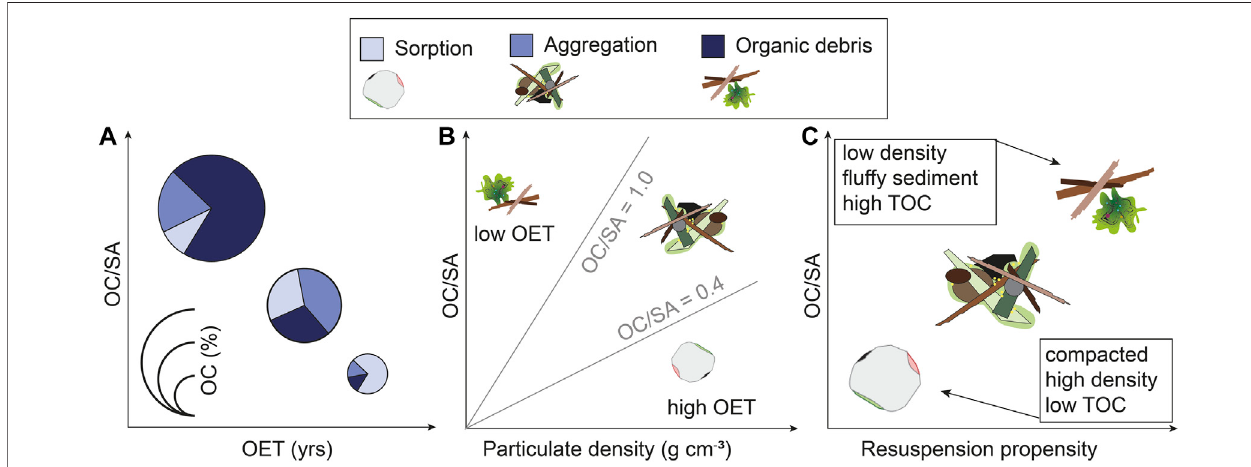
FIGURE 10 | Conceptual schematic illustrating the different factors interacting with each other to result in fl occulent ( fl uffy) ocean surface sediment and its preferential lateral transport. (A) With increasing oxygen exposure time, the absolute amount of OC in sediment decreases. In addition, the type of association between the OC and the mineral surfaces will change, from free organic debris to aggregates to sorbed OC due to the preferential degradation of less strongly bound/protected OC (cf., Arnarson and Keil, 2007; Bergamaschi et al., 1997; Burdige, 2007). (B) With increasing particulate density, we fi nd that the absolute amount of OC in sedimentdecreases.Ontopofthat,thetypeofassociationchangesaswell,fromfreeorganicmatter(lowdensity/highOC/SA)tosorption(highdensity,lowOC/SA)(cf., Arnarson and Keil, 2001; Blair and Aller, 2012). (C) An increase in a sediment ’ s propensity for resuspension requires high OC/SA ratios, and low-density aggregates, fl uffy sediment, or organic debris. Compacted, high-density sediment with little OC%, possibly sorbed tomineral surfaces, will have a lower propensity for resuspension (cf., Jepsen et al., 1997; Mayer,